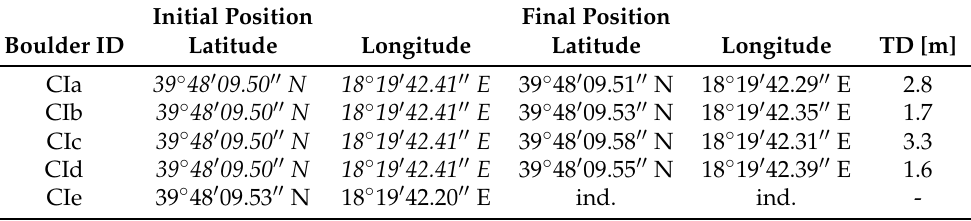
Table A13. Initial and final geographical coordinates of the displaced boulders at the Ciardo coast; ind.,